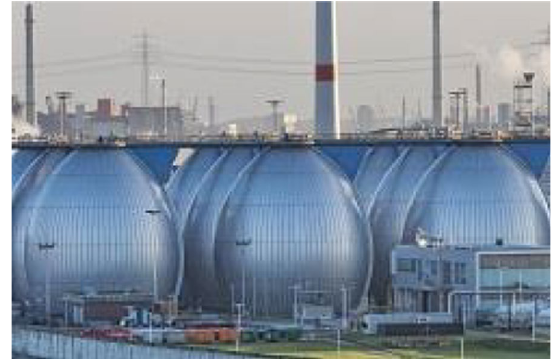
Fig. 18 A picture of the desalination plant in Barcelona (Adeleye et al.